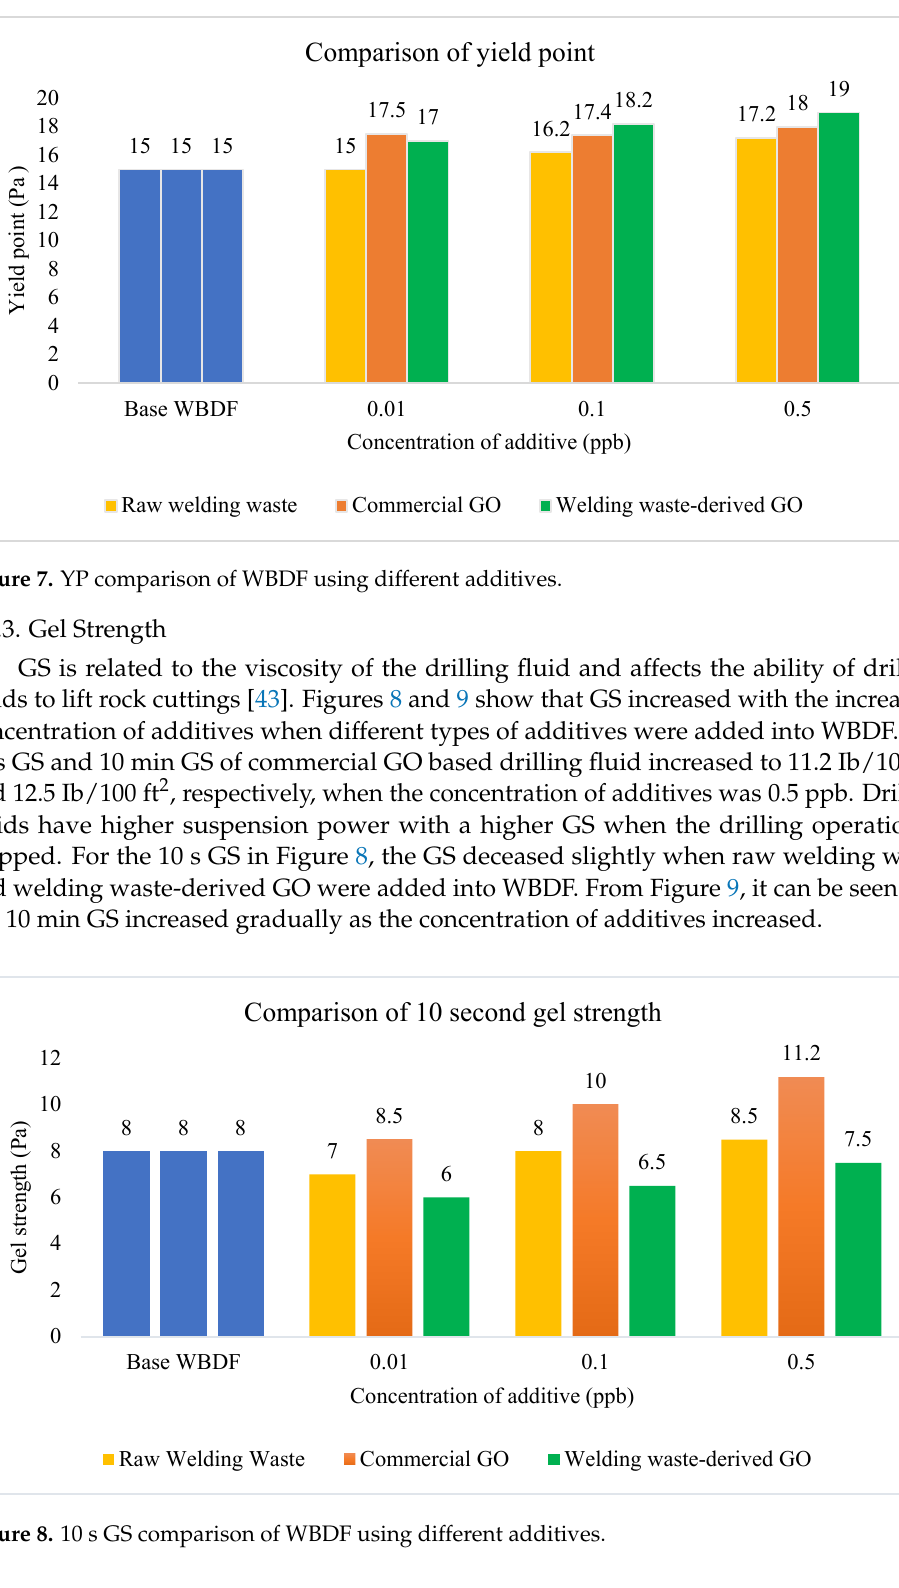
Figure 9. 10 min GS comparison of WBDF using different additives. 3.2.4. Filtrate Loss The FL of the three types of drilling fluid at the different concentrations of 0.01 ppb, 0.1 ppb and 0.5 ppb is shown in Figure 10. The base fluid displayed a filtrate loss volume of 9 mL. The fluid loss was significantly reduced to 6.6, 5.8 and 4 mL after the addition of 0.5, 0.1 and 0.01 wt% of GO nanoparticles to the WBDF, respectively, as shown in Figure 9. Raw welding waste-derived GO drilling fluid with 0.01 ppb shows the best result as the FL decreased from 9 mL to 4 mL—the highest reduction. The GO nanoparticles remarka- bly minimize the permeability and porosity of the mud cake [44]. By consolidating the attractive force between the particles, the volume of FL is reduced. On the other hand, when the amount of welding waste-derived GO was increased, the FL also increased. The usage of GO as a drilling fluid additive is likely because it has a special surface area of 2391 m 2 /g [13]. This acts as a solid penetrating layer that can make the formation of mud cake in drilling mud stronger, thereby preventing the mud from flooding into the formation. Furthermore, GO possesses another interesting characteristic, namely separa- tion of the solution and the formation of a strong paper-shaped material capable of effi- ciently preventing drilling mud leaks into the well wall. For instance, dispersed GO flakes can be filtered out of the solution and pressed to make a strong paper-like material, which